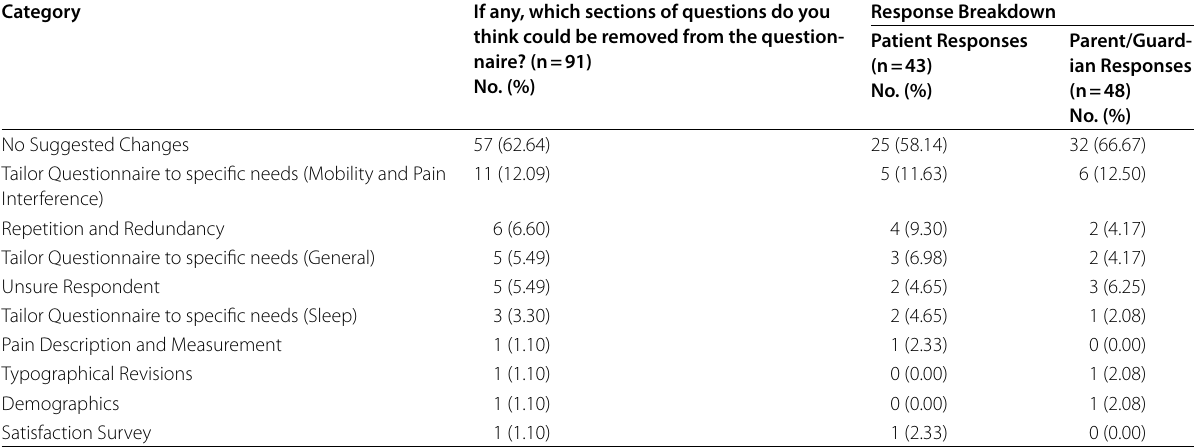
Table 3 *Distribution of Survey Comments on what to Remove from the Questionnaire